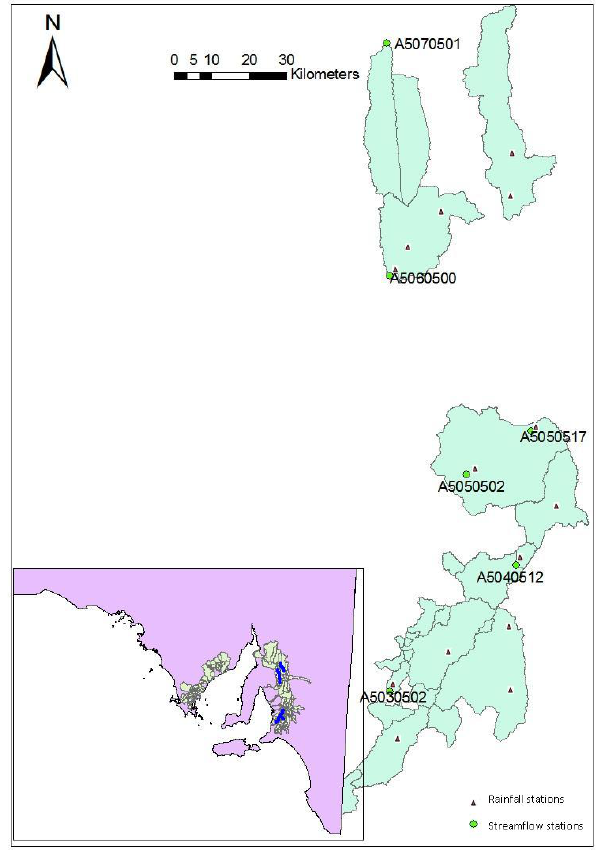
Fig. 1. Location map of the study